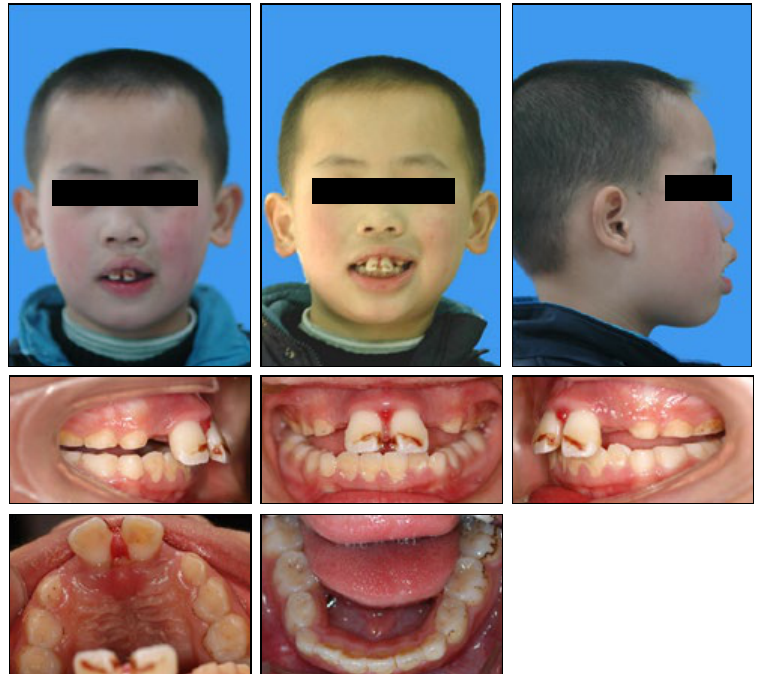
Figure 1. Phase one pretreatment photographs.